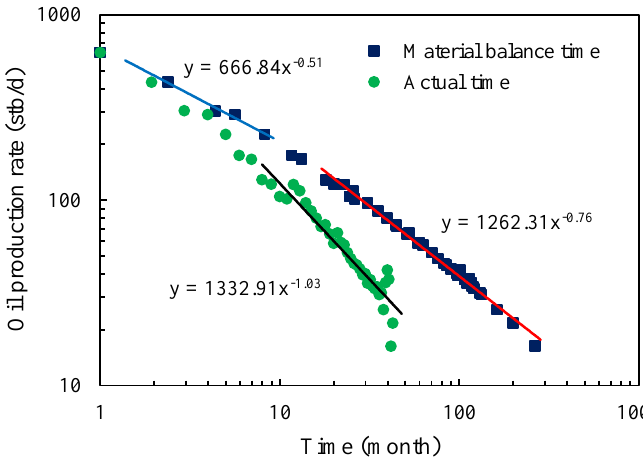
Figure 7. Plot of production rate data for Well #2.